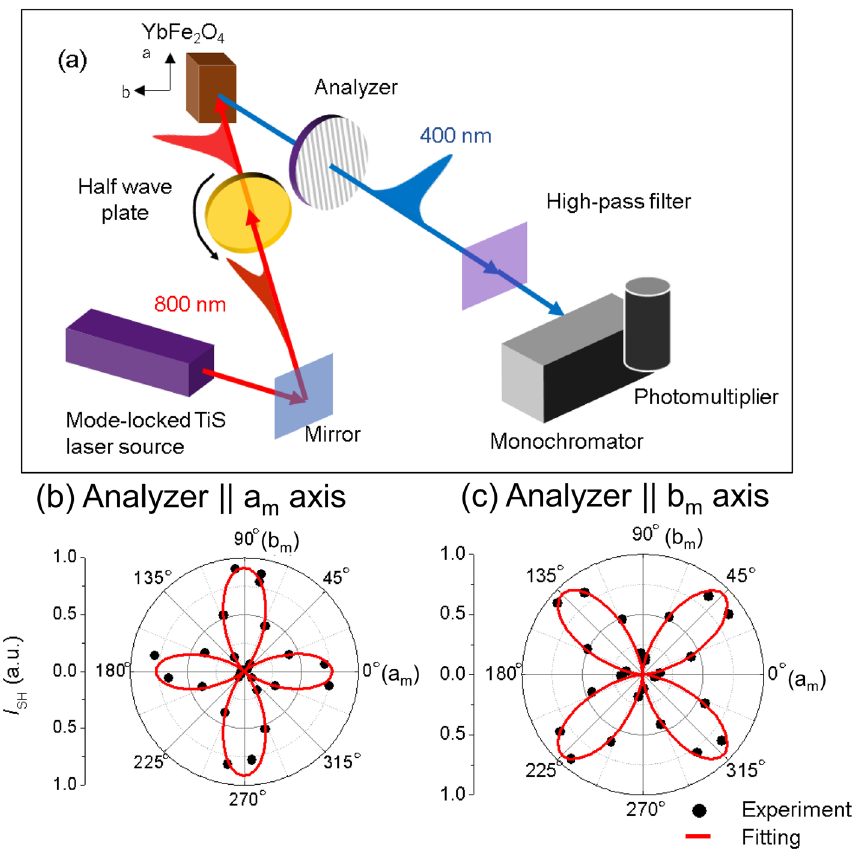
Figure 2. ( a ) Schematic diagram of the optical setup for the SHG polarization angle dependence measurement in the 00 L h (axis inset) of YbFe 2 O 4 . The red line represents incident light and the blue line represents reflected light. ( b , c ) Angle dependence ( θ ) of the SHG measurement. The black circles represent the experimental measurements and the red lines shows the fitting results based on the space group